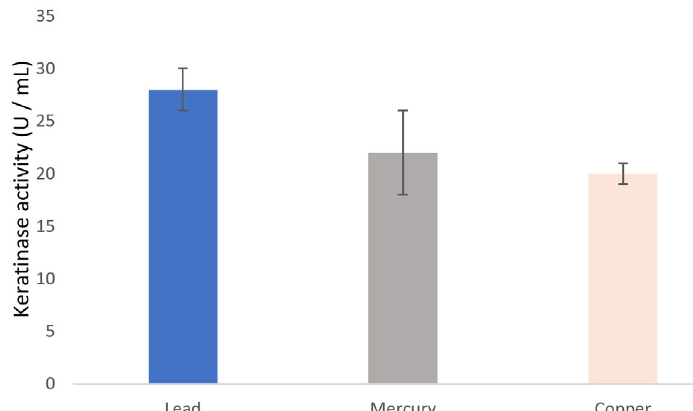
Fig. 4. Optimization of keratinase enzyme production presence of heavy metals.